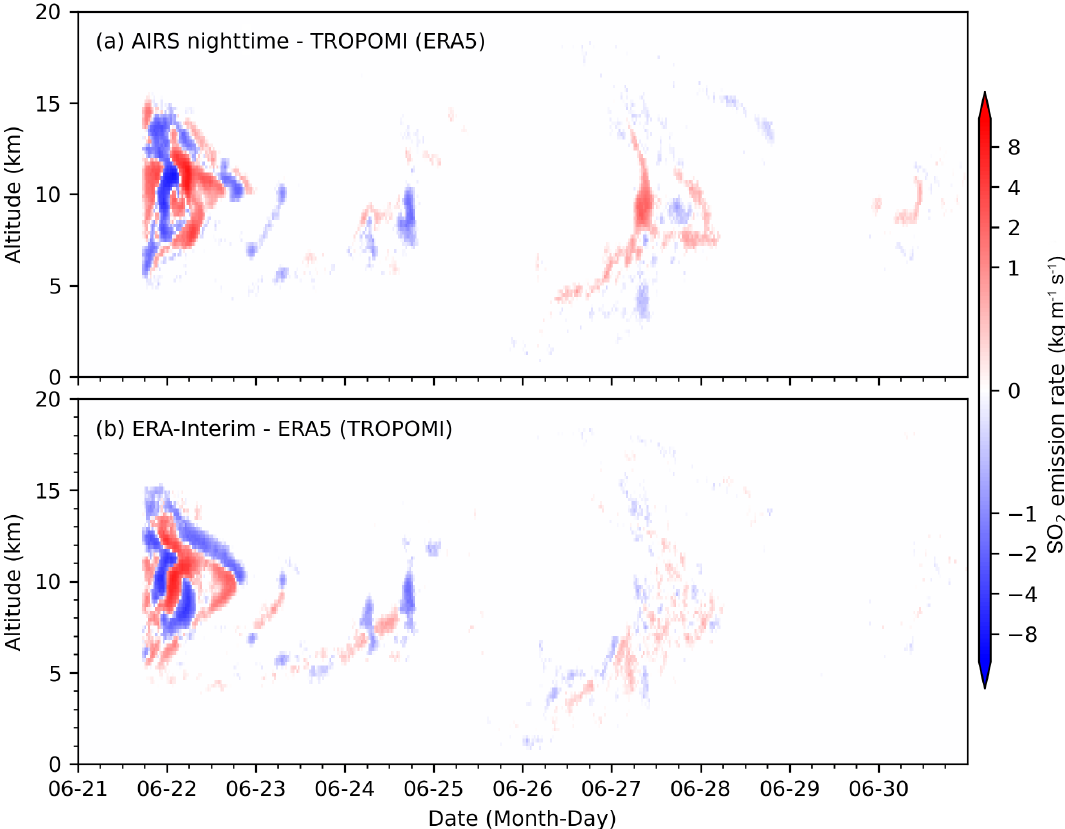
Figure 7. Differences in reconstructed SO 2 injections of the 2019 Raikoke eruption derived from different combinations of satellite products and reanalysis data compared with the TROPOMI-ERA5 combination: AIRS nighttime with ERA5 (a) and TROPOMI with ERA-Interim (b)